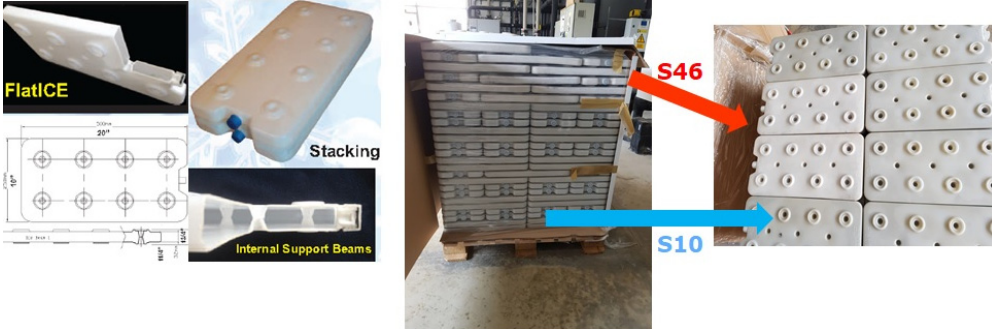
Figure 12. FlatICE containers installed in the CIESOL building (based on [34]).